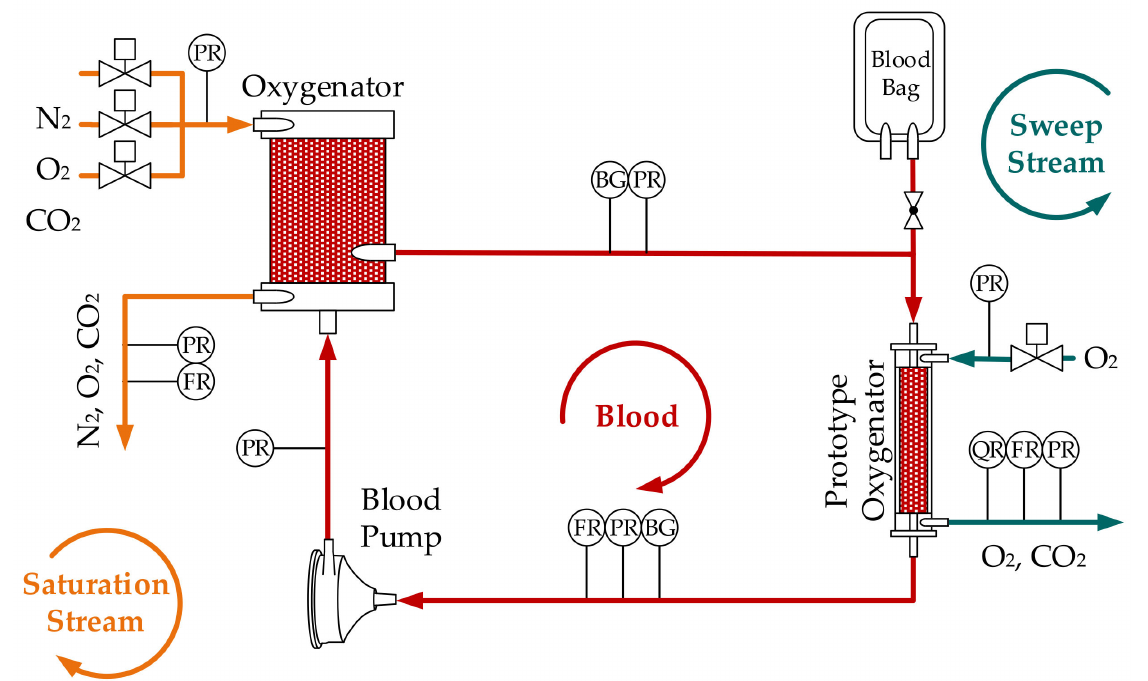
Figure 1. Scheme of the in vitro test setup with prototype oxygenator, blood pump, pressure sensors (PR), flow rate sensors (FR), blood gas analyzer (BGA) sample ports (BG), and CO 2 concentration sensor